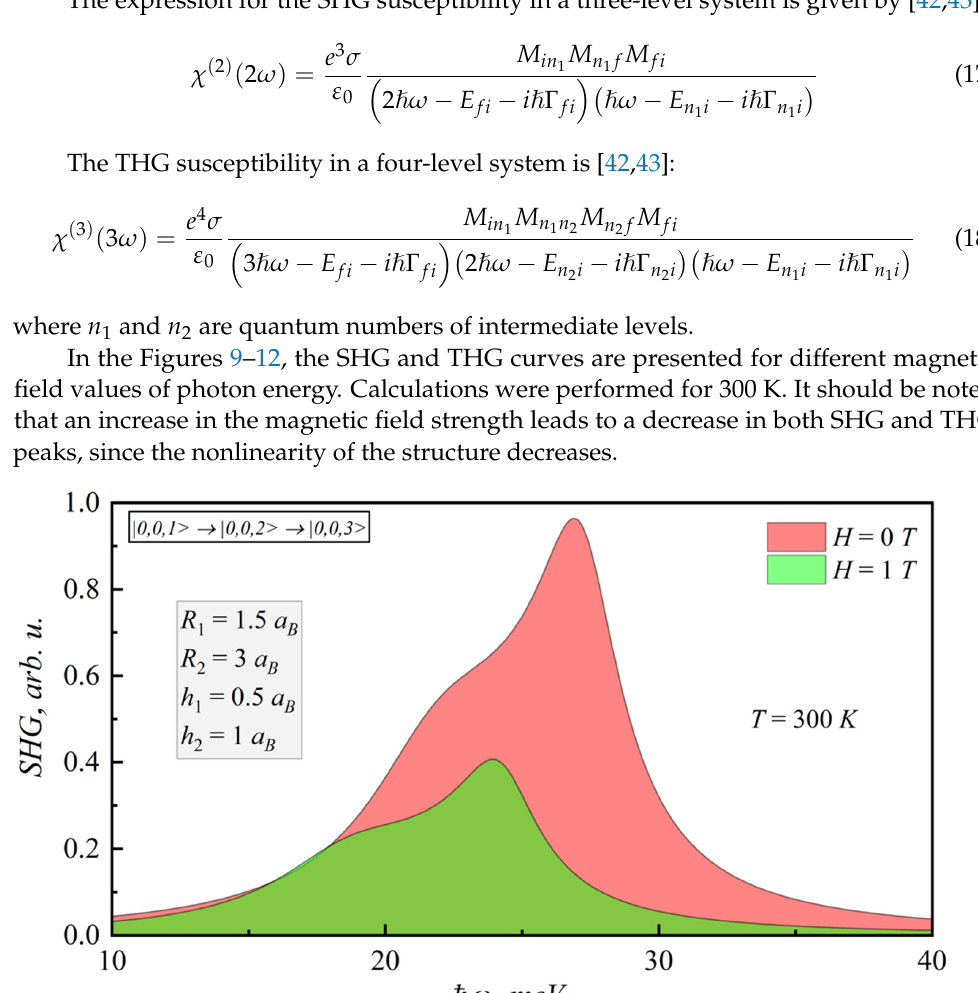
Figure 9. Dependence of SHG coefficient on photonenergy for different magnetic fields.